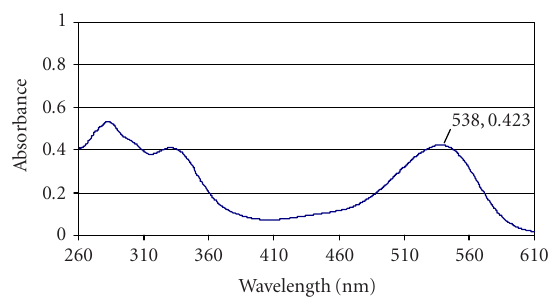
Figure 1. Scan spectrum of blueberry extracts in